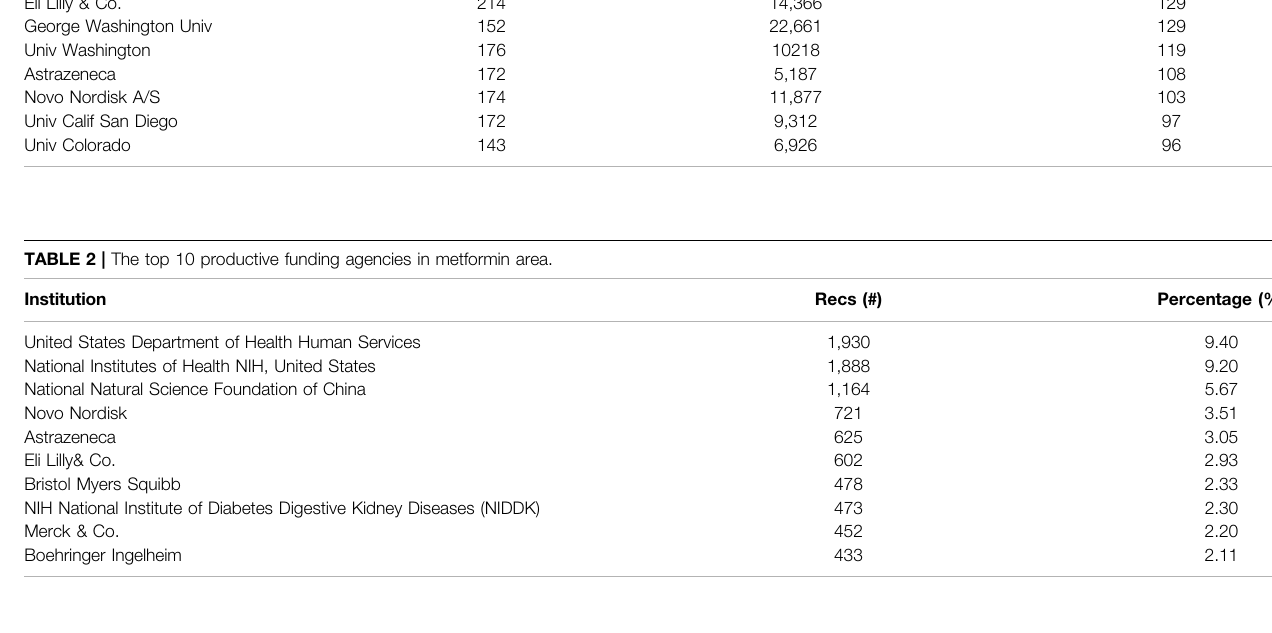
TABLE 3 | The top 15 productive institutions in terms of Recs and TGCS in metformin area.